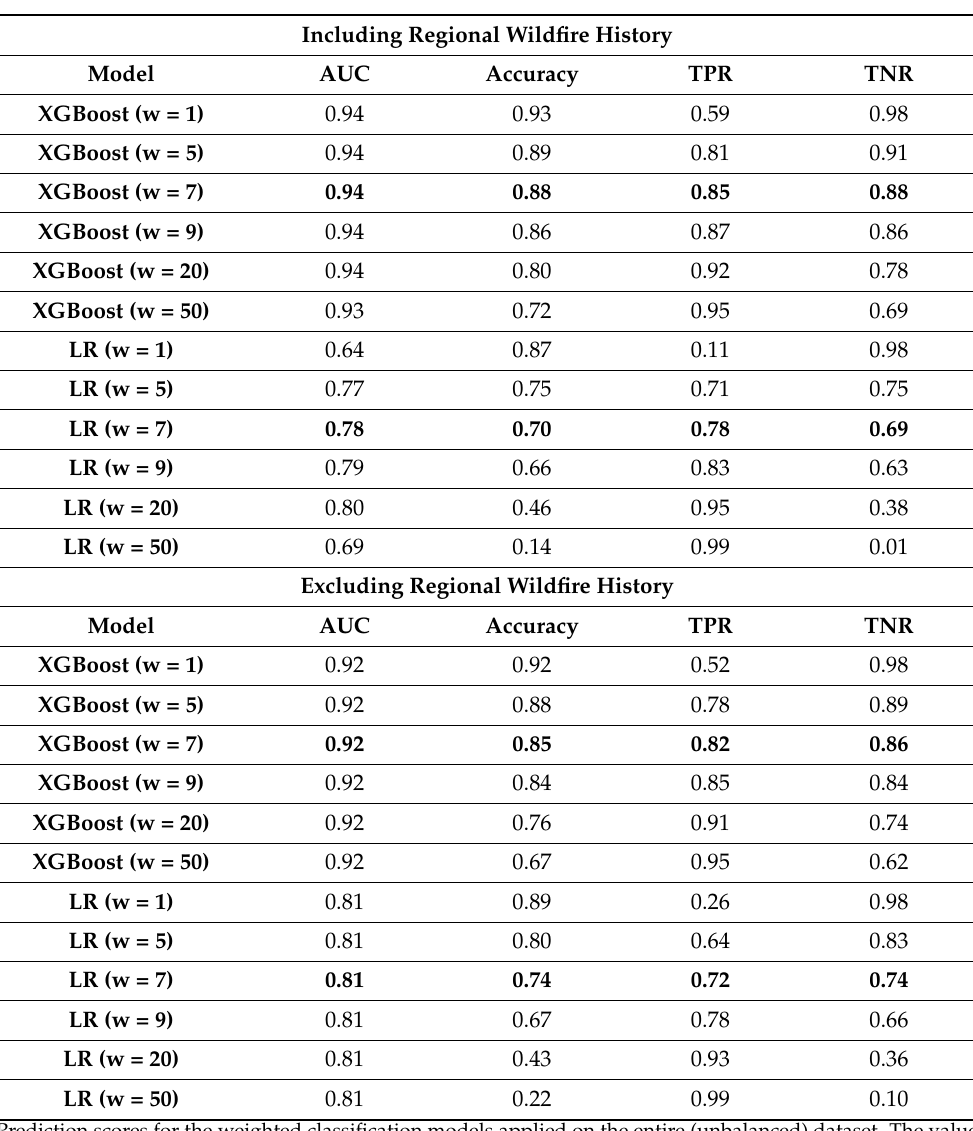
Table 3. Summary of model performances—weighted wildfire